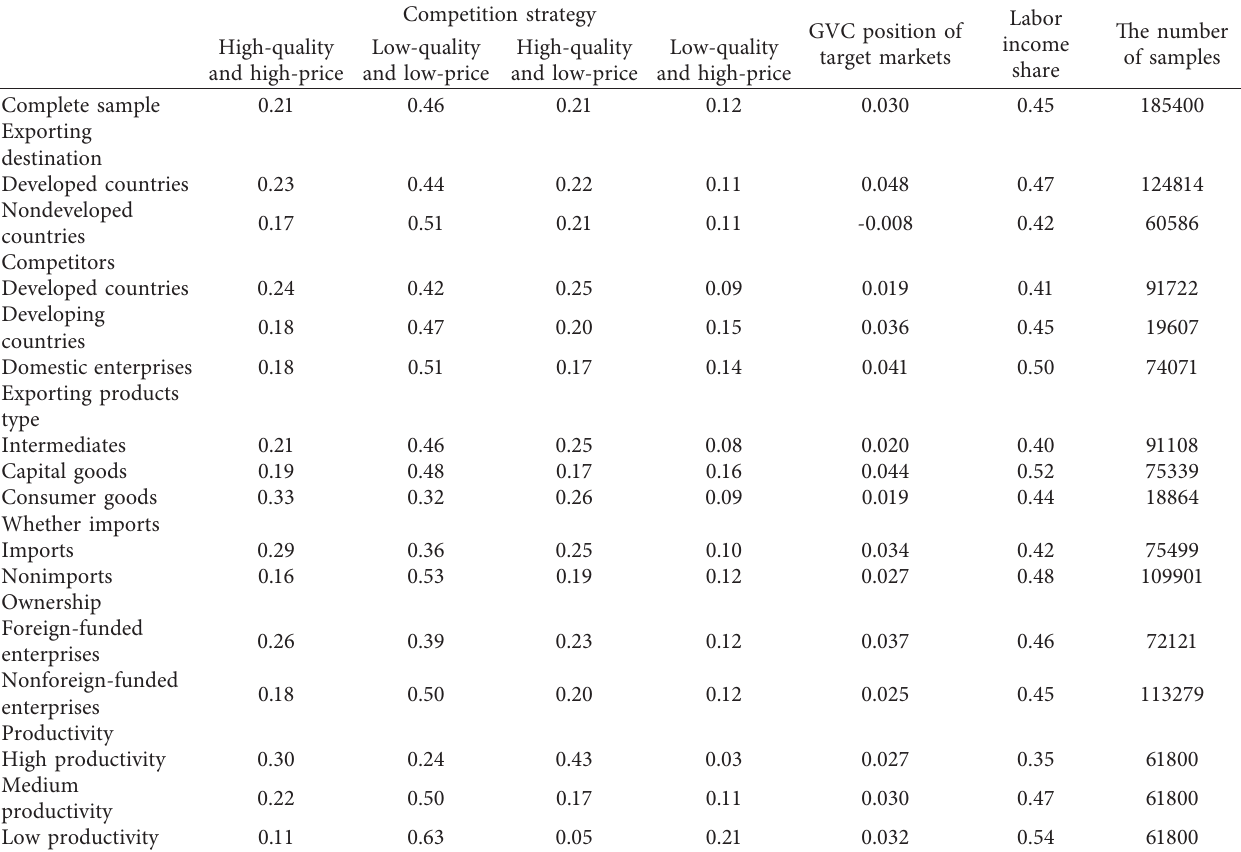
Table 1: Description of China’s manufacturing exporting enterprises. Competition